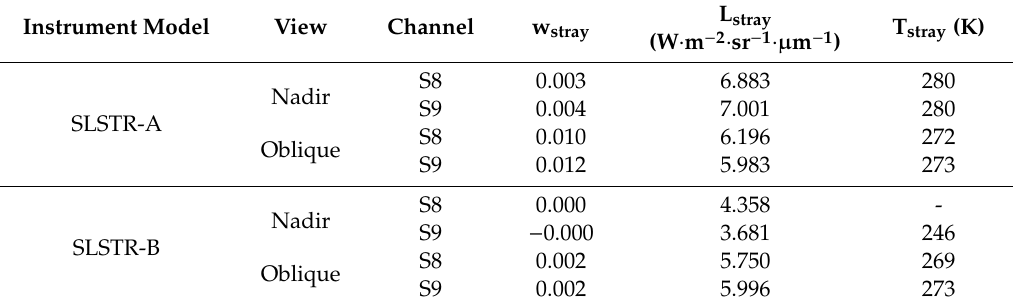
Table 7. Coe ffi cients w stray and L stray and T stray for the basic stray light model. Instrument